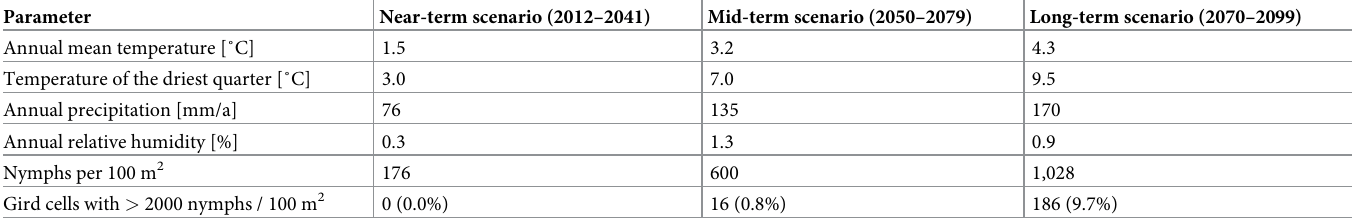
The values are given as difference to the reference period